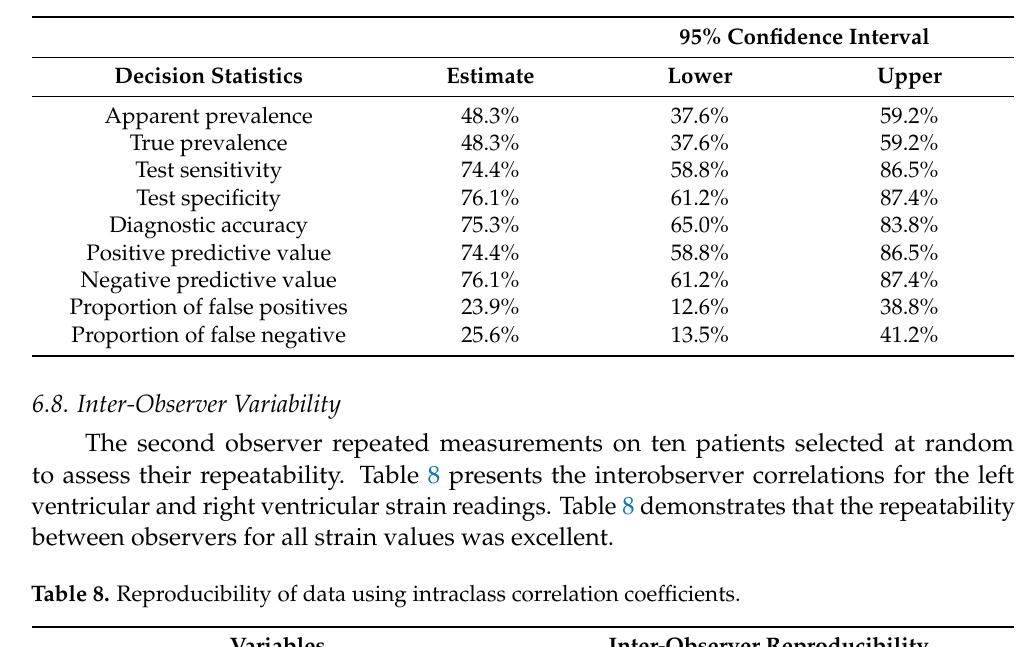
Table 7. Clinical Utility of LVEF, RVGLS, and Hb as predictors in assessing MIO.